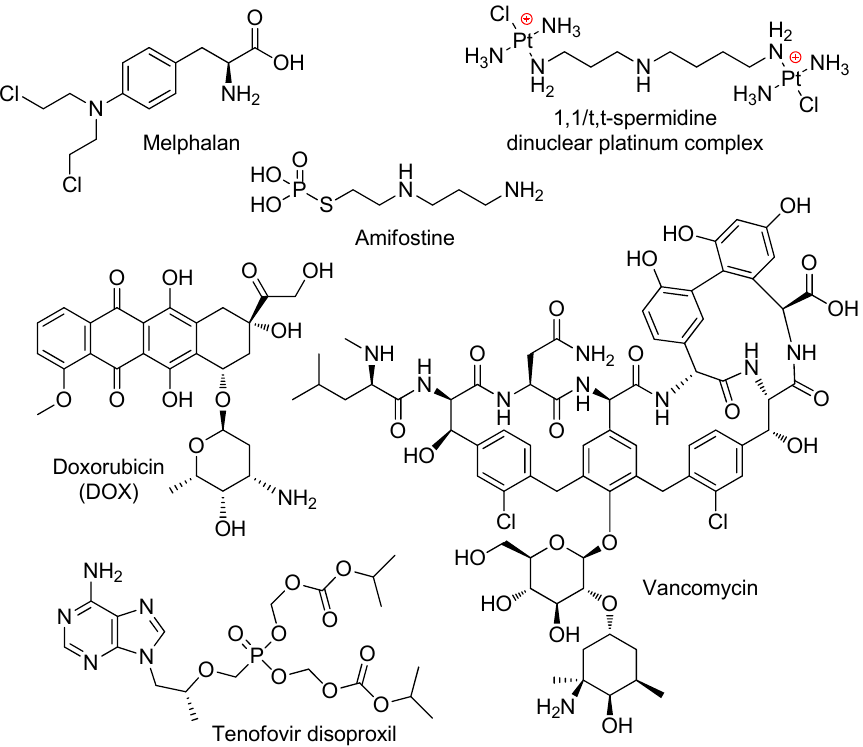
Scheme 31. Structural formula of the medications studied in drug delivery and release with the use of polyphosphodiesters.